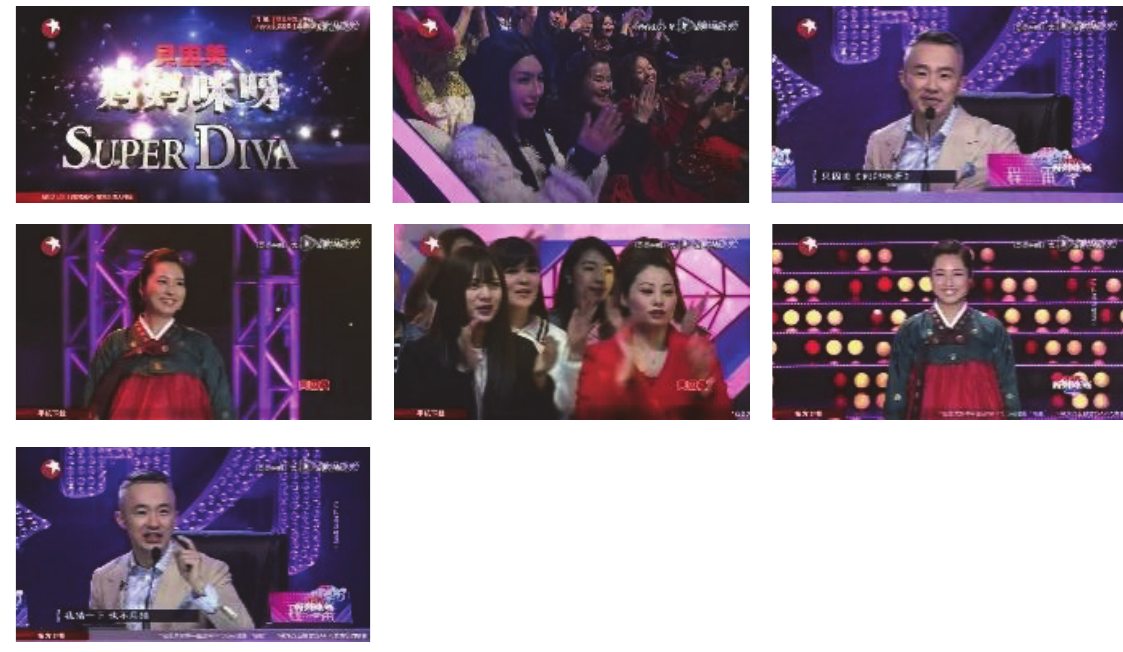
Figure 7: Examples of final key frames extracted from Figure 6.